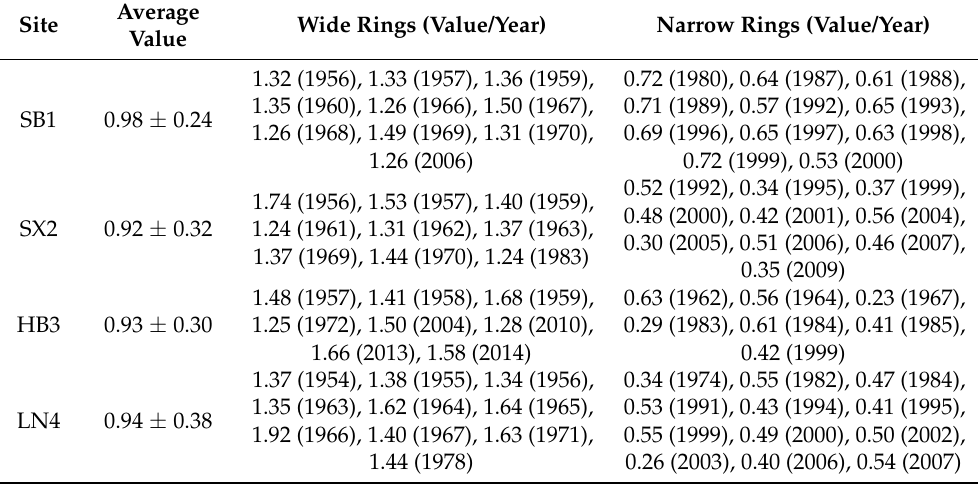
Table 2. Years of extremely wide rings and narrow